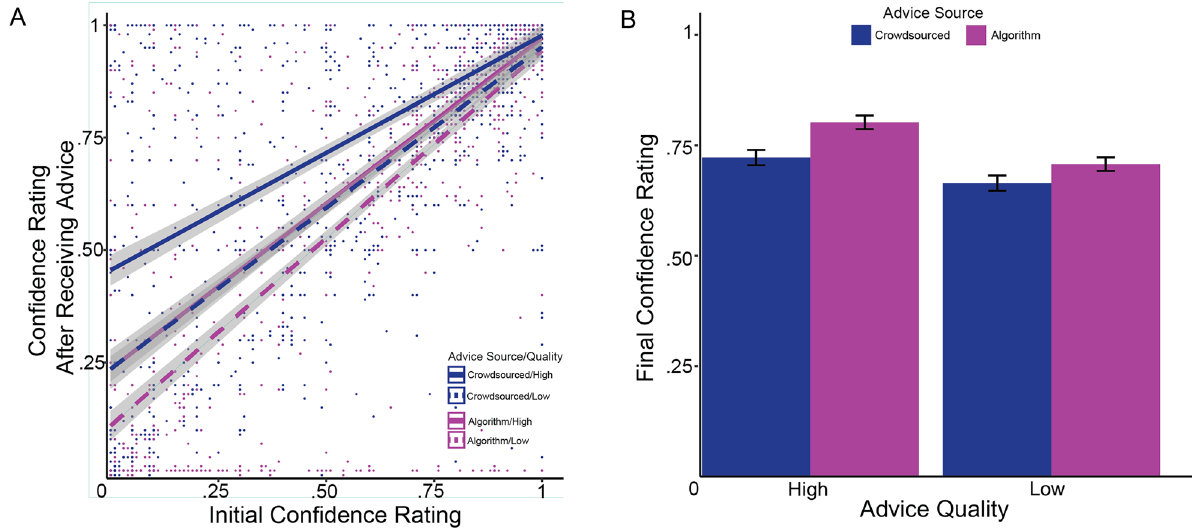
Figure 4. Relationship between advice source, quality of advice, and confidence. ( A ) The relationship between participants’ Initial Confidence and Final Confidence, broken down by advice source and quality. Purple lines indicate algorithmic advice, and solid lines indicate high quality advice. All lines are linear best fits with 95% confidence bands. ( B ) The estimated marginal mean Final Confidence, accounting for initial confidence. Error bars represent one standard deviation. All pairwise differences between marginal means are statistically significant at p < 0.01 using Tukey’s multiple comparison